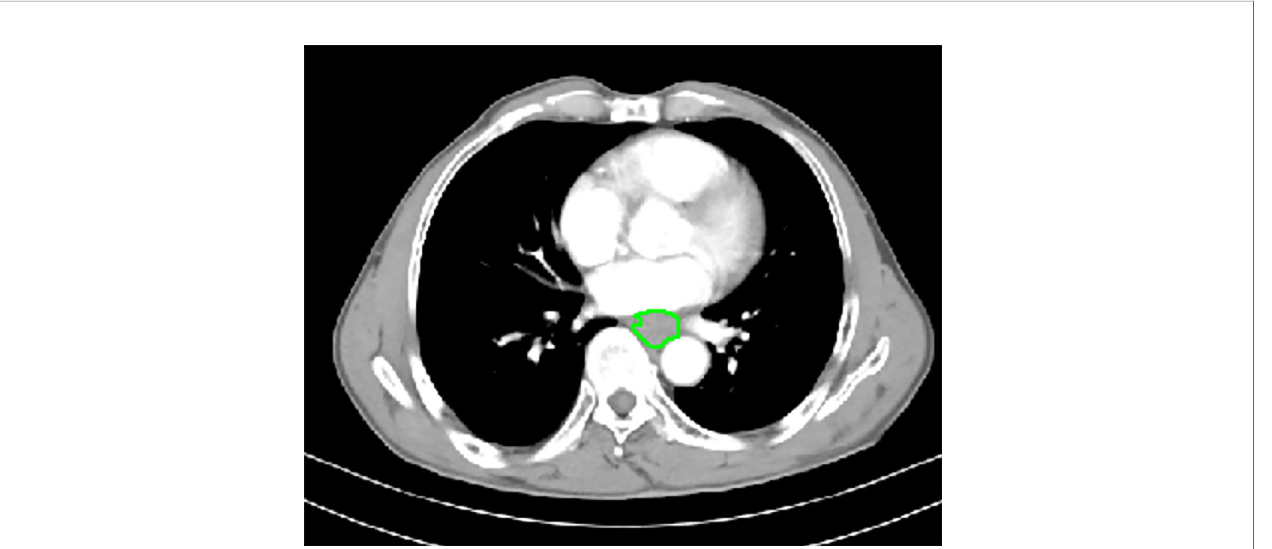
FIGURE 2 | In a 66-year-old male with esophageal squamous cell carcinoma at cT 3 N 0 M 0 , the preoperative thoracic contrast-enhanced CT scans depict the gross tumor volume obtained by manual delineation along the margin of the abnormal esophageal wall slice-by-slice, and the gross tumor volume is 12.83 cm 3 . During the follow-up period, there was no recurrence as shown on follow-up CT after radical